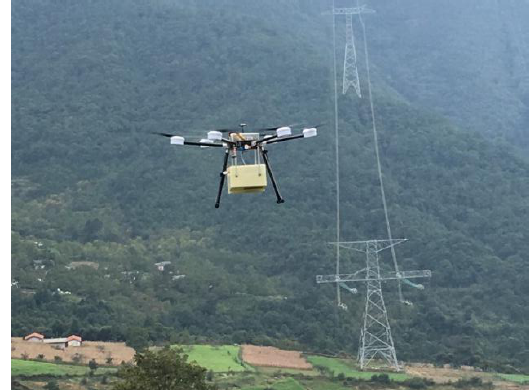
Figure 1. Power line inspection